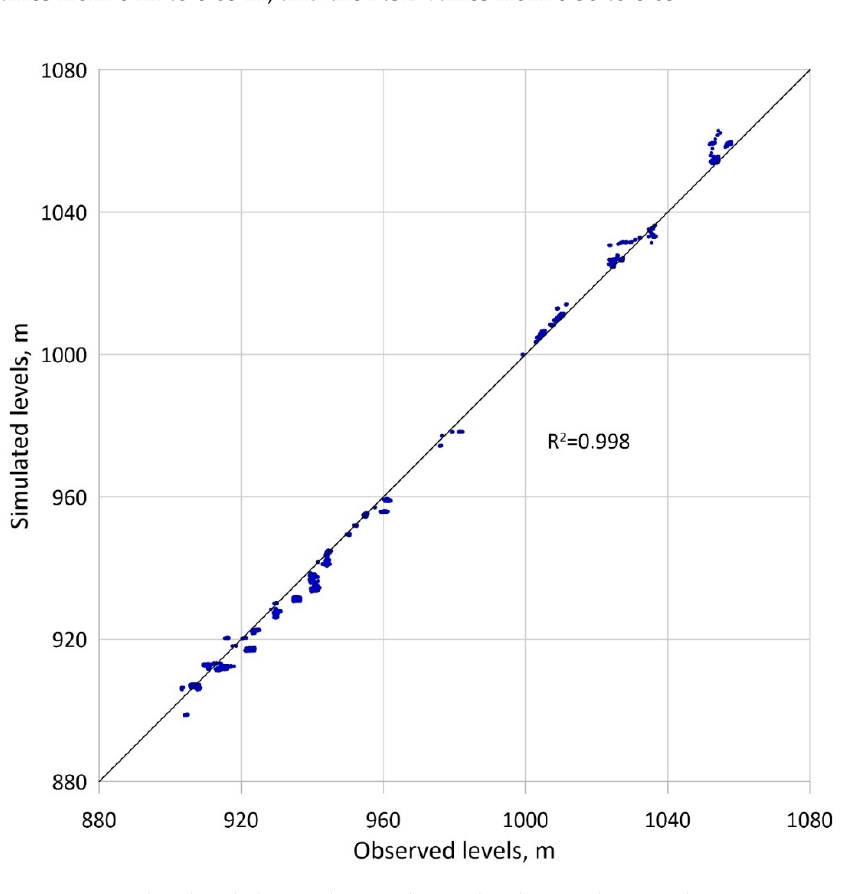
Figure 10. Simulated and observed groundwater levels over the period 2000–2017.